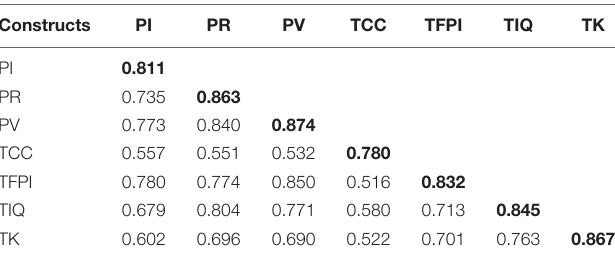
TABLE 4 | Discriminant validity analysis.